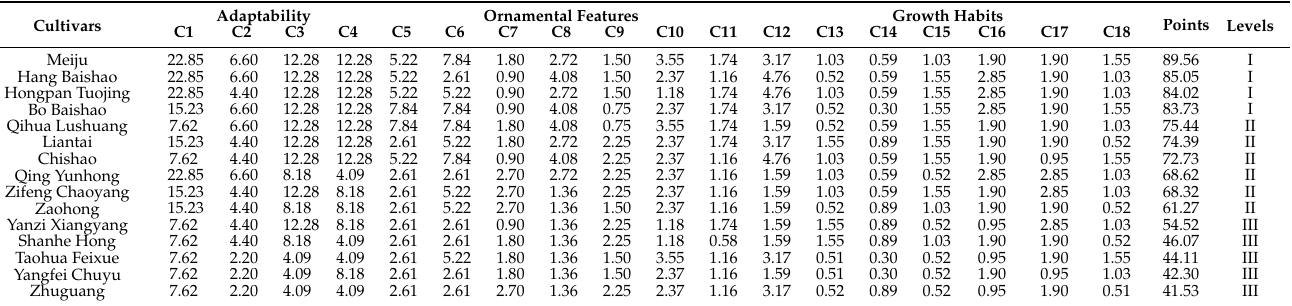
Table 3. Statistics of comprehensive evaluation points and rating levels of the fifteen herbaceous peony